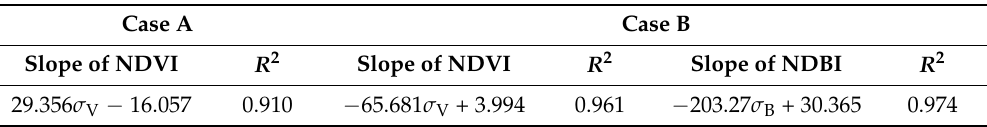
Table 5. The functions for predicting the slopes of descriptors in the regression functions for downscaling Landsat-8 TIRS LST with GRM on 31 July 2013.